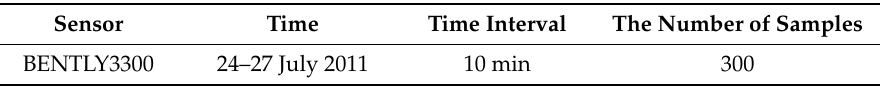
Table 2. Detailed description of the monitoring data.